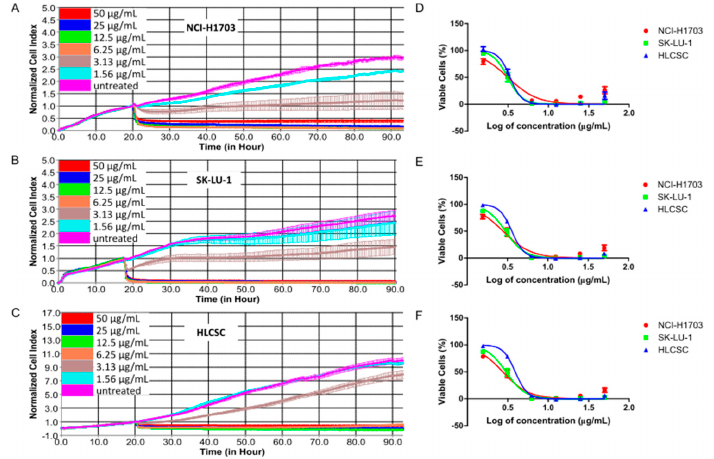
Figure 1. Dose–response curves of chelerythrine chloride treatments in NCI ‐ H1703, SK ‐ LU ‐ 1,